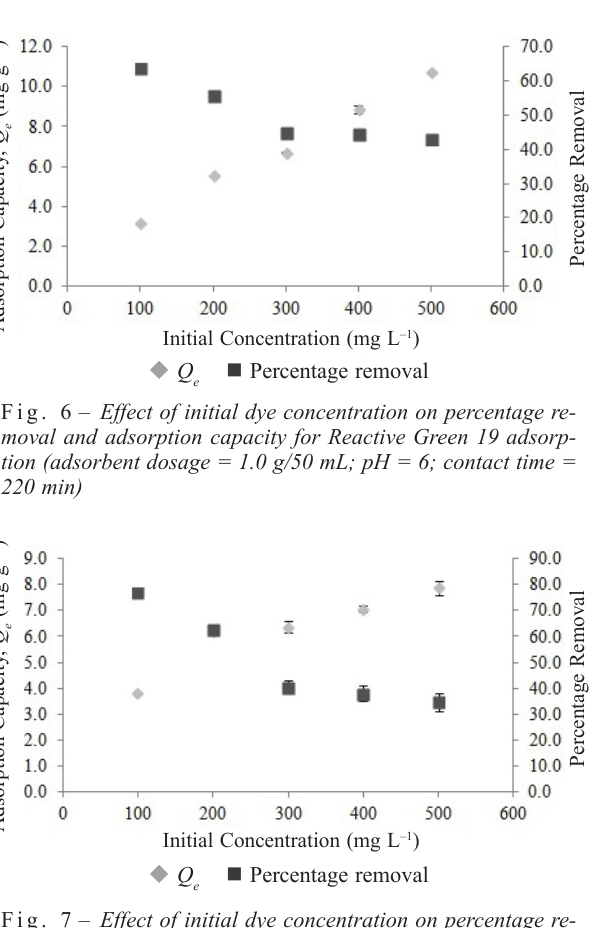
Fig. 7 – Effect of initial dye concentration on percentage re- moval and adsorption capacity for Reactive Red 141 adsorp- tion (adsorbent dosage = 1.0 g/50 mL; pH = 6; contact time = 180